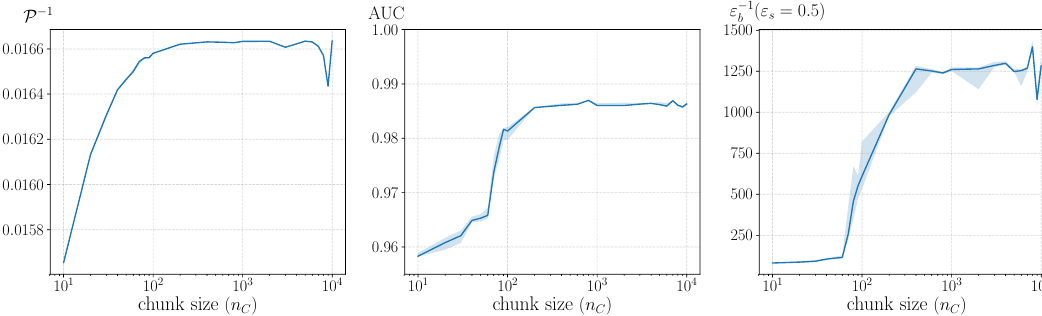
Figure 19 . The inverse perplexity (left), AUC (center), and inverse mistag rate (right) as functions of the chunk size for a mixed W 0 /QCD event sample with 10 4 events and a chunk size equal to the size of the event sample. The o(cid:11)set is also varied such that the learning rate is held constant. The calculations were done for 100 di(cid:11)erent random seeds, the blue lines show the mean of these and the shaded regions cover the upper and lower standard deviations. Separate upper and lower standard deviations are used to show how the actual variances in the performance statistics are typically skewed heavily towards the negative